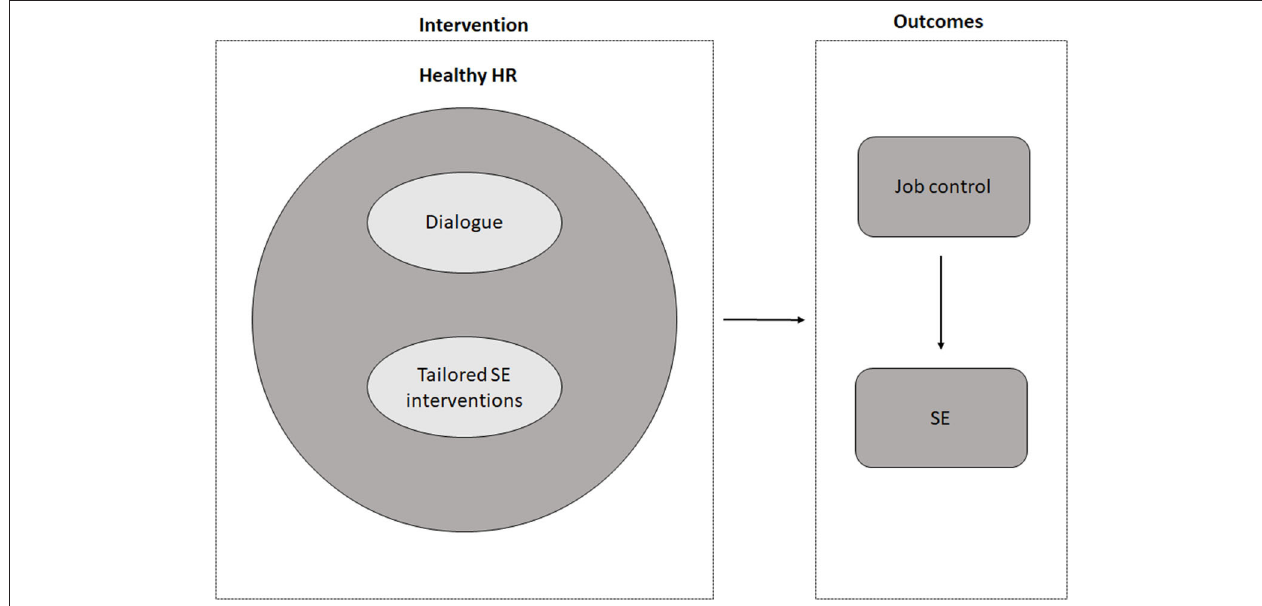
FIGURE 1 | Conceptual model of HHR and expected